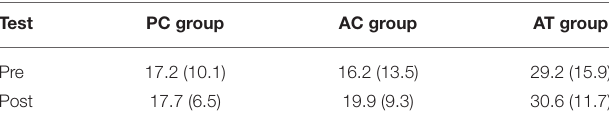
TABLE 6 | Percentage of matrix problems solved by old adults at pre- and